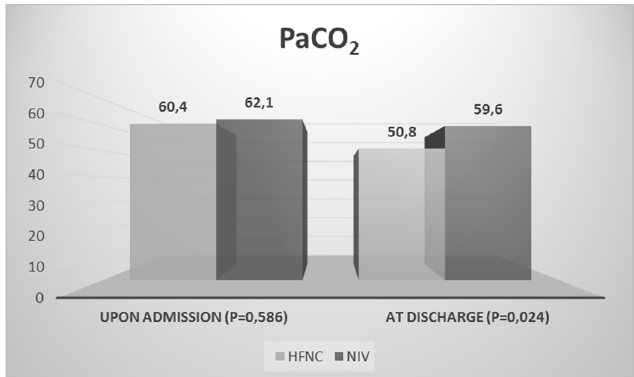
Figure 1. PaCO 2 of the two groups upon admission to the hospital and after discharge.